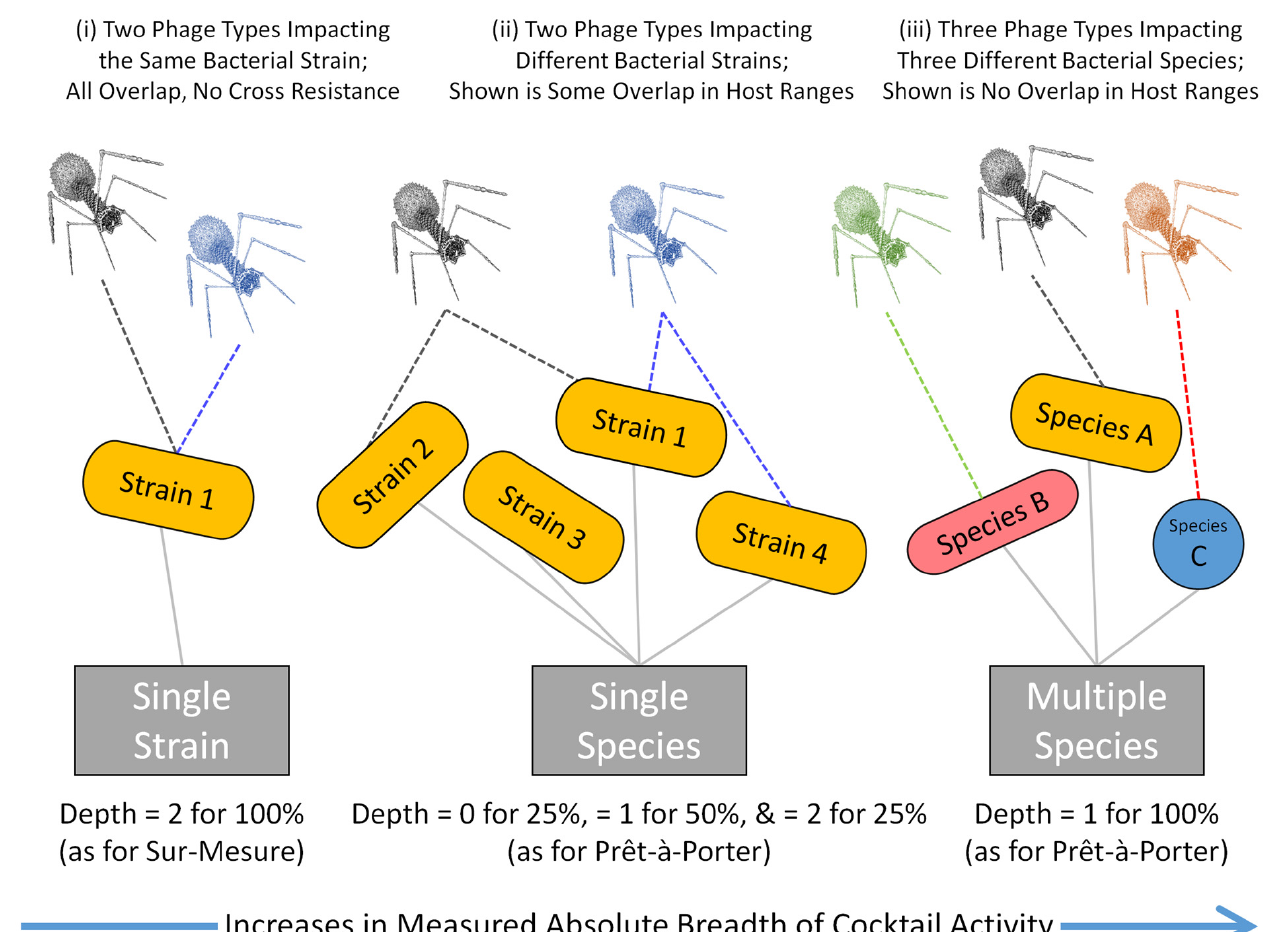
Figure 1. Variations in phage cocktail breadth and depth of activity. Phage cocktails can be designed to impact multiple species ( right ), multiple strains of a single species ( middle ), or just a single bacterial strain ( left ). Our emphasis here primarily is toward combining the properties of the middle category with those of the leftward category. “Sur-mesure” means that a cocktail is custom-made or personalized; “Pr ê t- à -porter” is translated literally as ‘ready-to-wear’, but meaning here that it is not custom made for a specific patient. Spectrum of activity breadth can be considered in absolute terms, e.g., impacting one species versus impacting three species (see the arrow at the bottom of the figure). Spectrum of activity breadth can also be considered in relative terms, e.g., impacting 75% rather than 100% of the strains making up a single bacterial species. This latter concept we describe below as “Breadth 1 ”, read as “Breadth subscript 1”. Spectrum of activity depth refers to how many phages target a single, specific bacterial strain, especially given an inability of that bacterial strain to mutate to cross resistance to the different phages. To the left, the cocktail targets a single bacterial strain, designated as “Strain 1” in the figure, with a depth of 2. This means that Strain 1 is being targeted by two different phages, especially two phages that are found in two different cross-resistance group. As this is the only strain shown to the left, and therefore is 100% of bacterial strains shown there, in the figure this is indicated as “Depth = 2 for 100%”. In the middle, with the cocktail targeting multiple strains of a single bacterial species, relative breadth of activity is 75% ( = percent strains with Depth ≥ 1), as impacting “Strain 1” (Depth = 2), “Strain 2” (Depth = 1), and “Strain 4” (Depth = 1), but not “Strain 3” (Depth = 0). Thus, for one-quarter of the strains the depth is equal to 0 (“Depth = 0 for 25%”), for one-half depth instead is equal to 1 (Depth “= 1 for 50%”), and for another one-quarter depth is equal to 2 (Depth “= 2 for 25%”). To the right, the cocktail is impacting three different bacterial species, A, B, and C, using three different phages. Relative breadth of activity there is 100% (percentage of shown strains targeted with Depth ≥ 1), but depth of activity is only 1 for each of those strains (“Depth = 1 for